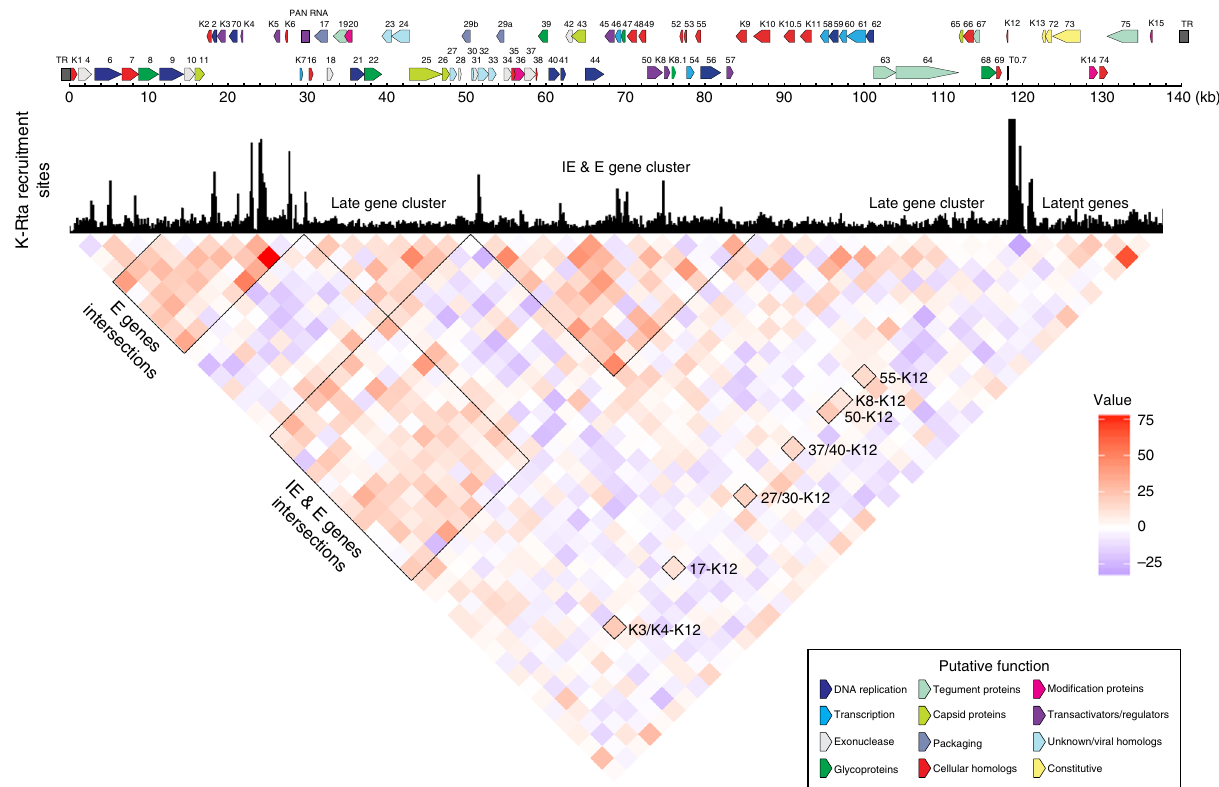
Fig. 3 Dynamics of KSHV genomic loop formation. Total sequence reads in 3 kb intervals were counted and divided by the number of Dpn II sites within the 3 kb-sequence. Sequence read count per Dpn II site was then divided by total sequence reads containing KSHV genome to obtain relative number of genomic loops at the respective genomic region. Relative increase/decrease of genomic links by induction of K-Rta was then obtained by subtracting the relative sequence reads of non-reactivated TREx-K-Rta BCBL-1 cells from those of reactivated TREx-K-Rta BCBL-1 cells, and visualized by heatmap by using R-program. The ChIP-seq results presented in Fig. 1b is superimposed above the heatmap to visualize the relationship between loop dynamics and K-Rta recruitment sites. Genomic clusters representing IE, E, and late genes are marked. Loci where genomic loops that increased during reactivation are marked by block borders, and increased genomic loops with the fragment containing K12 K-Rta RE are also identi fi ed with relevance to the Fig. (Fig. 6e, #5/#22). The results imply that activation of promoters is important for looping and that K-Rta is not required to be simultaneously bound to both fragments to form a genomic loop.